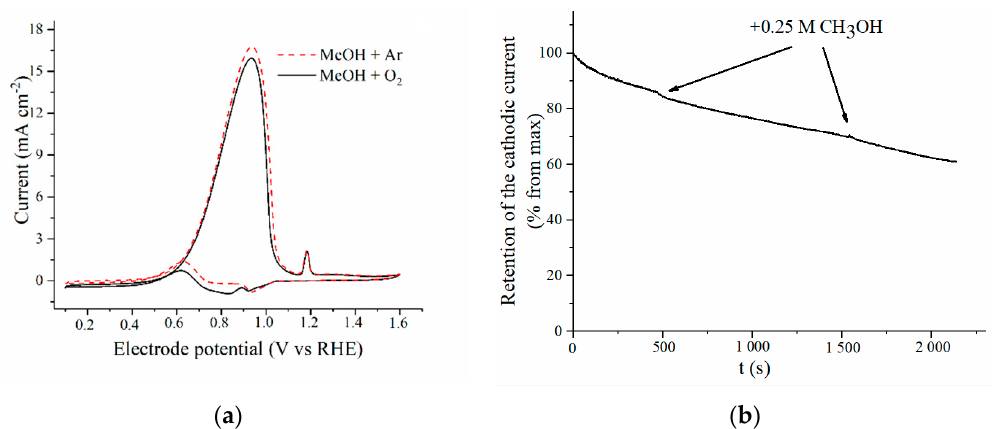
Figure 7. Stability of the mixed catalyst in the presence methanol in the electrolyte ( a ) CV curve of methanol oxidation on Pt / Cu (PC) mixed catalyst in Ar-saturated (dash line) and then O 2 -saturated (solid line) 0.2 M NaOH electrolyte with addition of 0.5 M CH 3 OH, ( b ) chronoamperogramm of Pt / Cu (PC) mixed catalyst in O 2 -saturated 0.2 M NaOH electrolyte with additions of 0.25 M CH 3 OH (at time, indicated by arrows), E = 0.7 V vs.